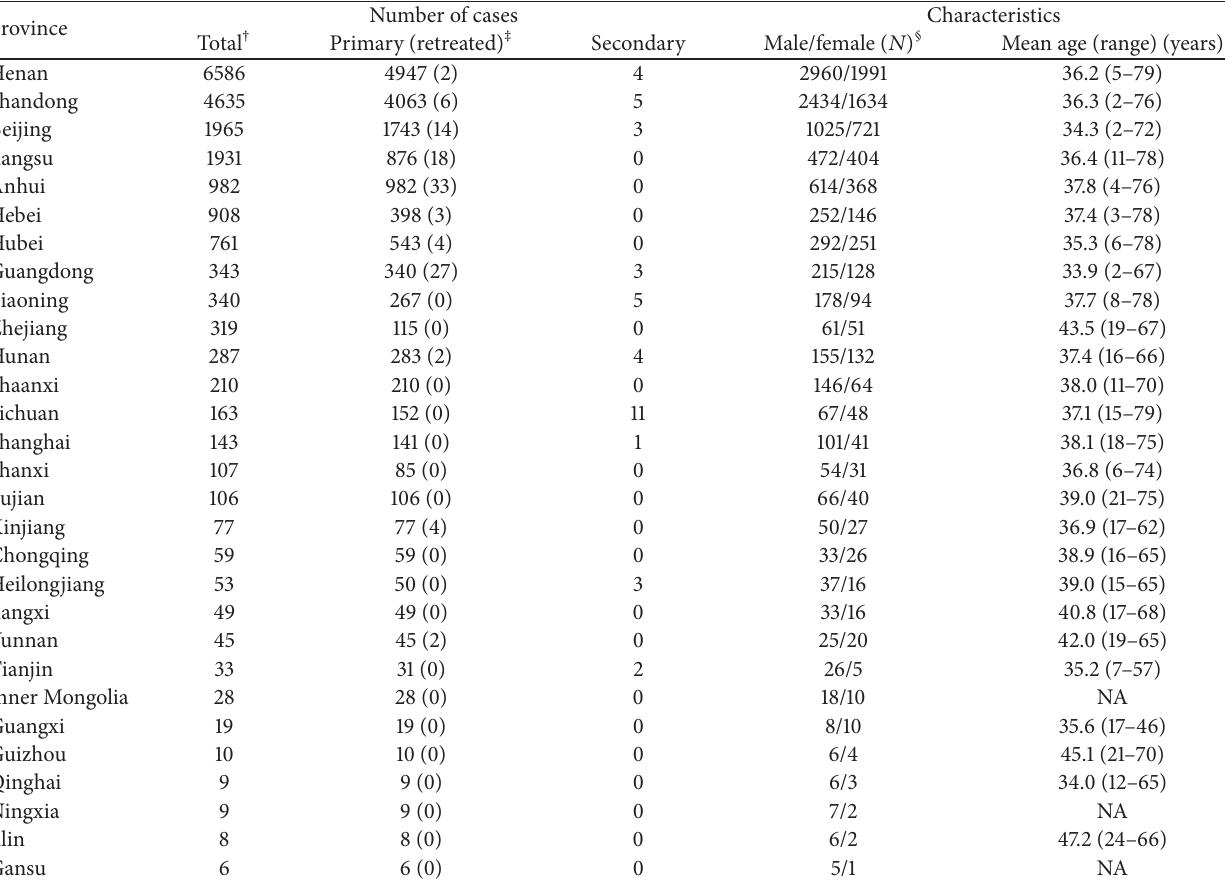
Table 2: Distribution and characteristics of BCS patients in China